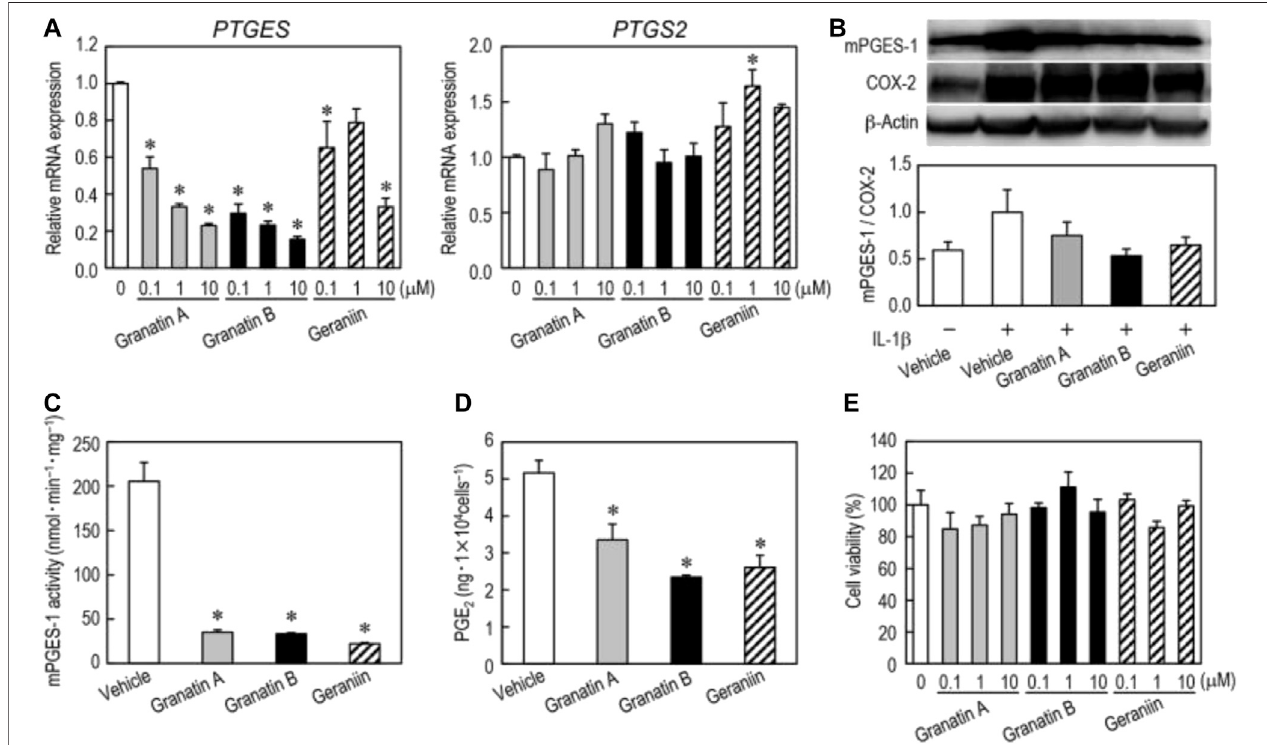
FIGURE 5 | Effects of granatin A, granatin B, and geraniin on mPGES-1 and COX-2 expression. Changes in mRNA and protein levels of mPGES-1 and COX-2 by treatmentwithgranatinA,granatinB,andgeraniinwereanalyzedbyreal-timePCRandwesternblotting.ReproducedfromTodaetal.,2020withpermissionfromTaylor and Francis Ltd. Copyright 2019.